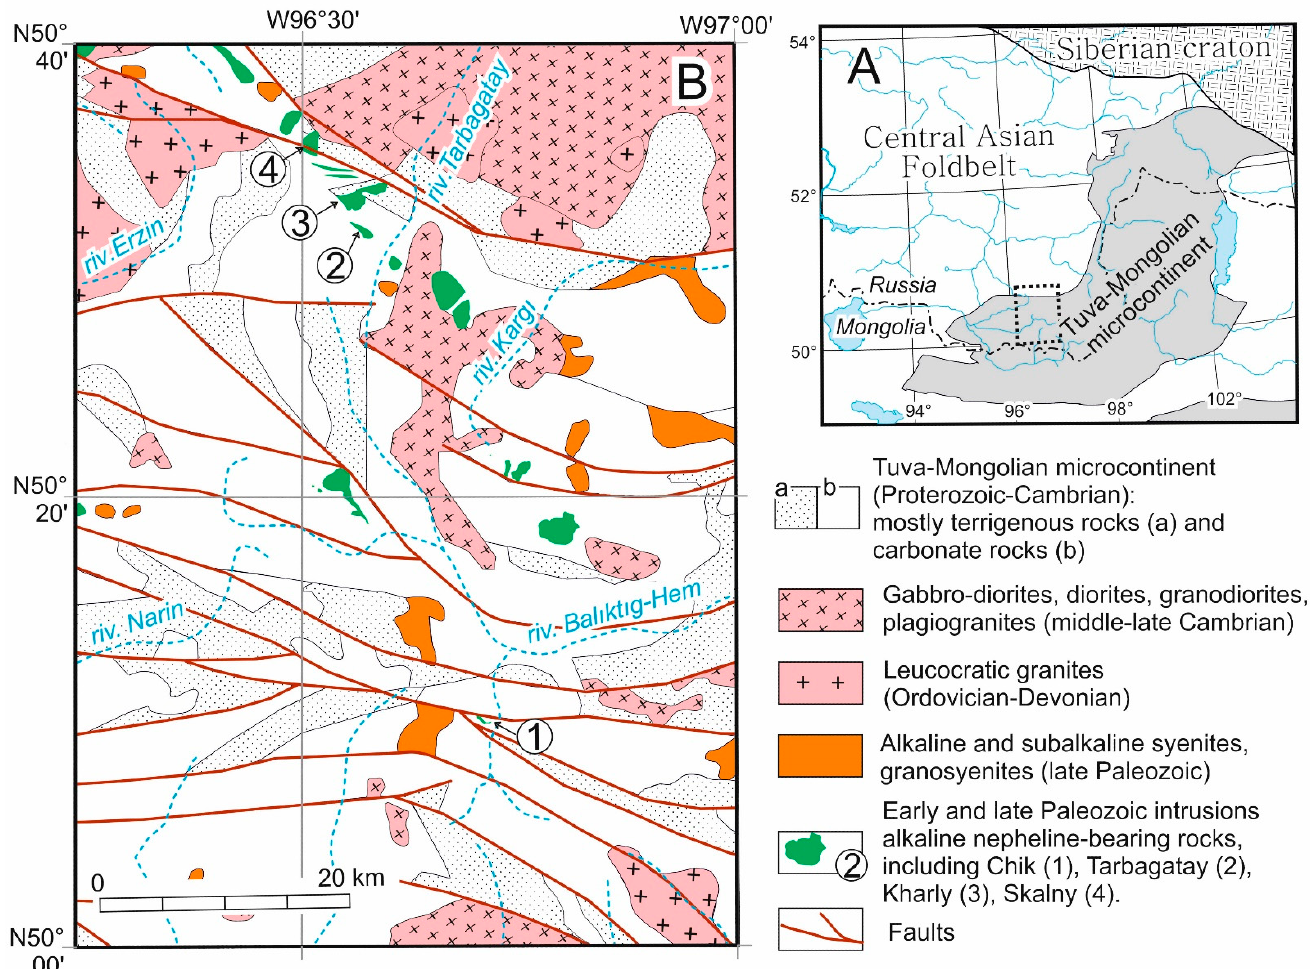
Figure 1. Location of the Tuva-Mongolian terrane ( A ) and intrusions of alkaline nepheline-bearing rocks on the geological Figure 1. Intrusions of alkaline nepheline-bearing rocks on the geological scheme of the central part of the Sangilen High- lands [28]. scheme of the central part of the Sangilen Highlands ( B )